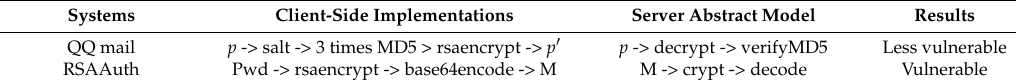
Table 2. Results for security analysis of Tencent QQ mail system version 2017 and